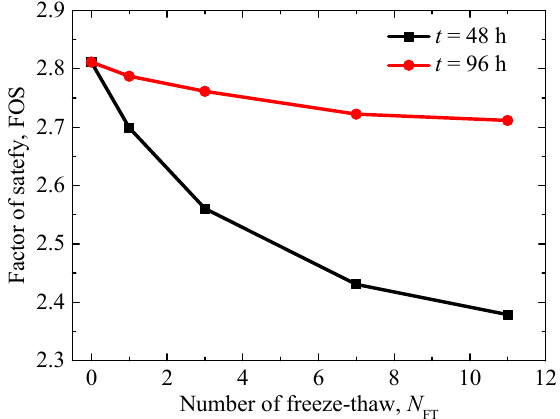
Figure 20. Factor of safety (FOS) of cutting slope along under various number of freeze-thaw cycles ( N FT ).